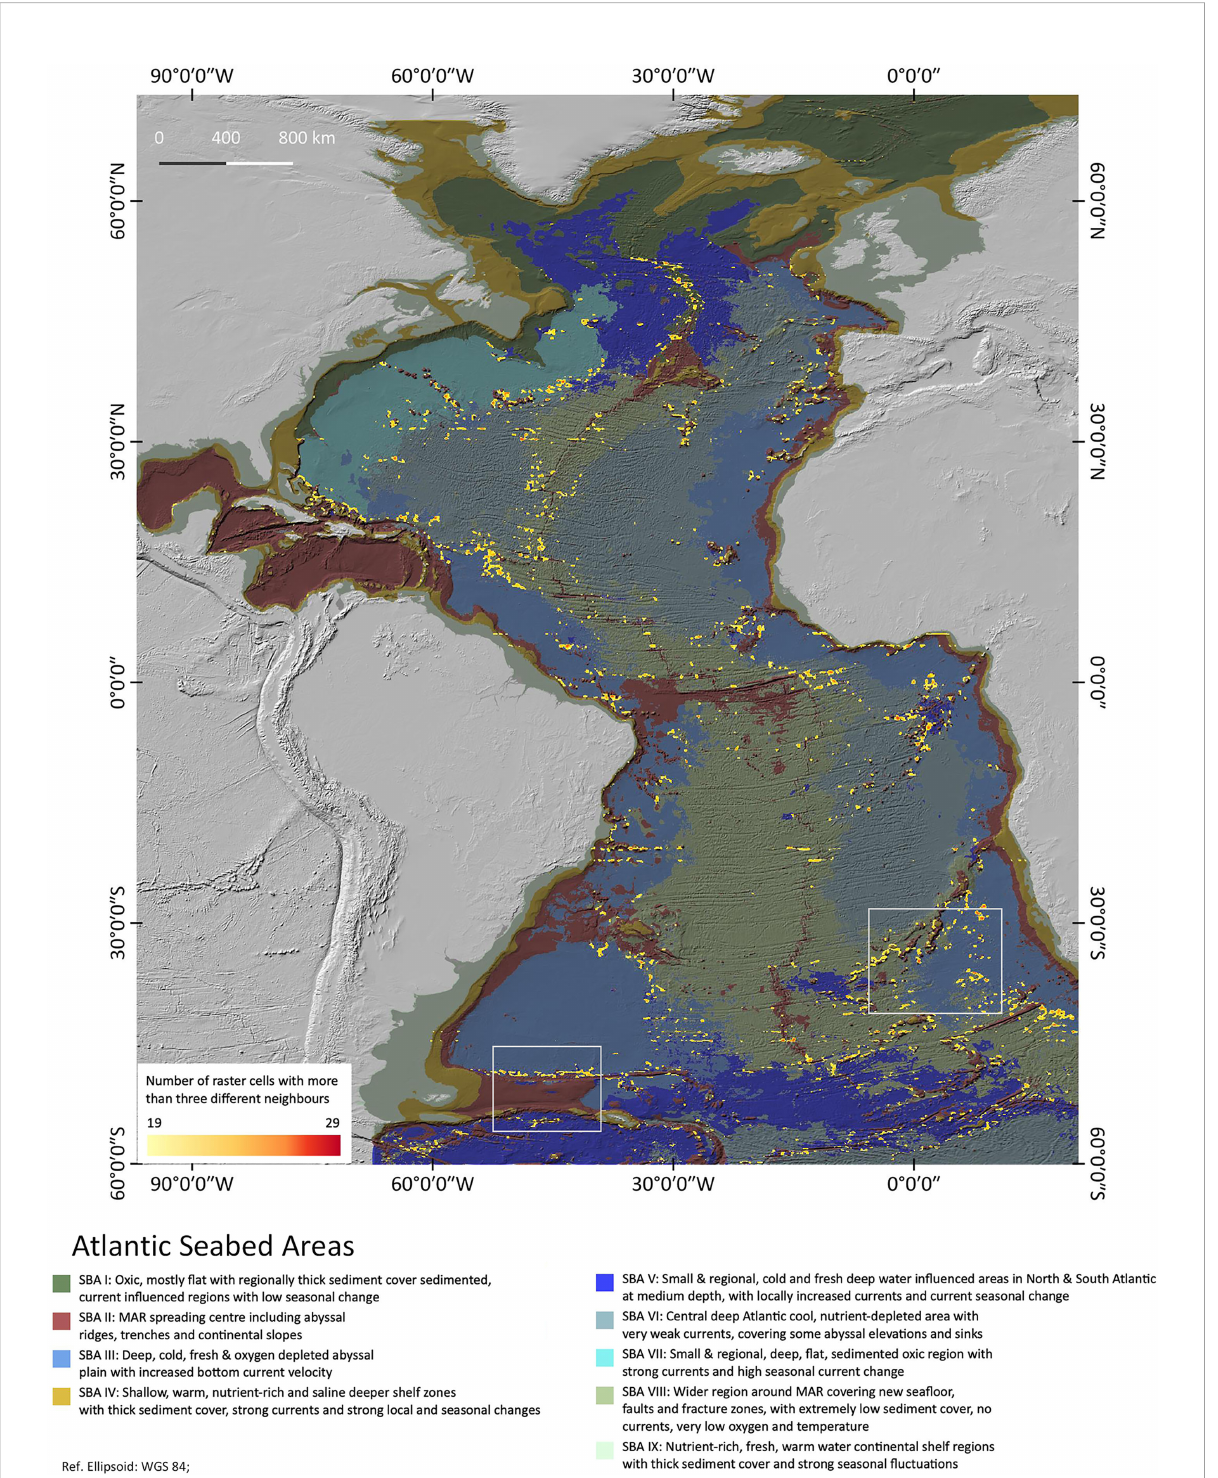
FIGURE 4 Atlantic Seabed Area diversity density. A patch richness analysis map highlighting areas of high SBA diversity. The boxed areas of Walvis ridge and Falkland Plateau are discussed in more detail below in Figures 5 and Figure